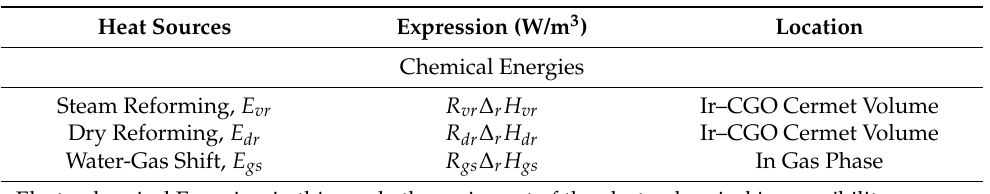
Table 5. Expressions of heat